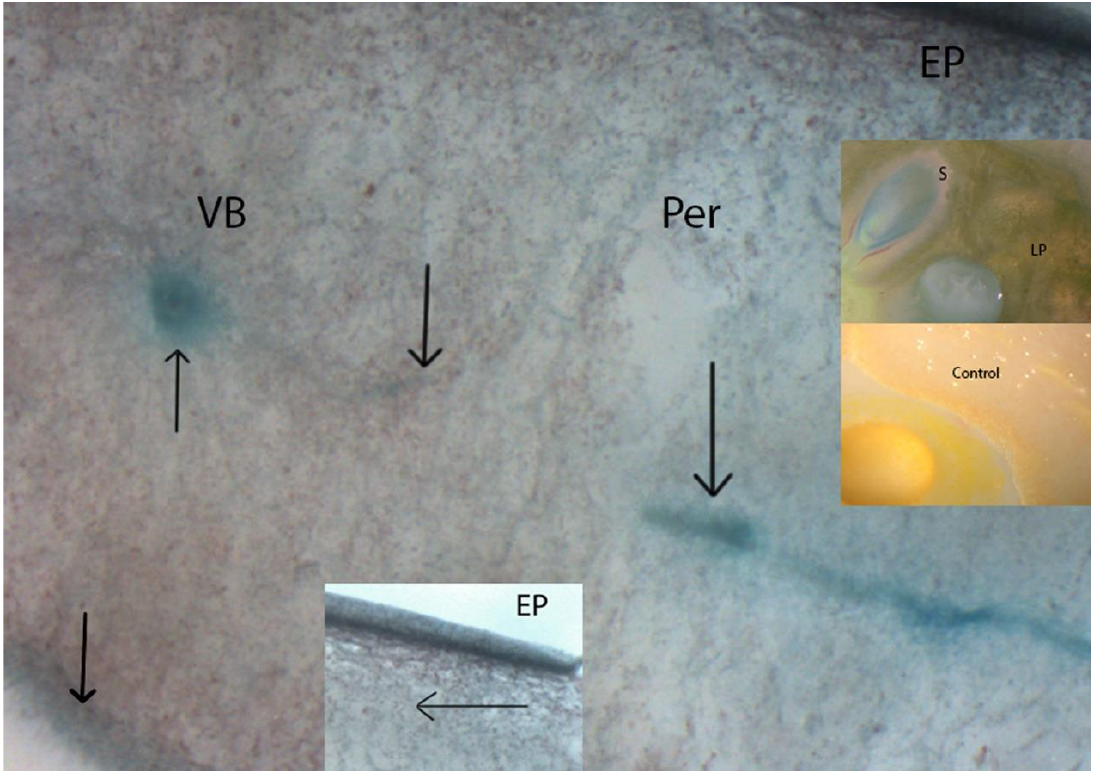
Figure 6. Localization of the β -GAL activity on different tomato fruit cv. Chondrokatsari segments at CM stage of fruit maturation. The enzyme activity was visualized as a darker stain. In1; control. VB; vascular bundle, LP; locular parenchyma, Per; pericarp, EP; epidermis, S; seed.